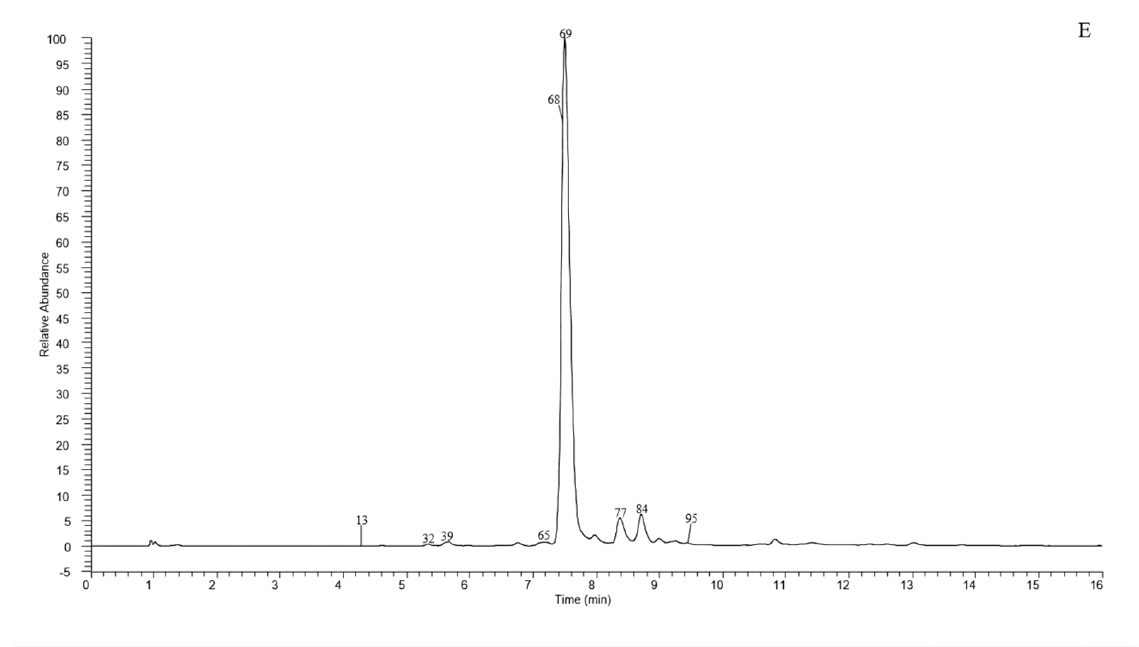
Figure 1. High-resolution extracted ion chromatogram (HREIC) in 5 ppm for multiple compounds in CT: ( A ) m / z 269.04554, 271.06119, 283.06119, 285.04046, 287.05611, 289.07176, 301.03537, 303.05102,